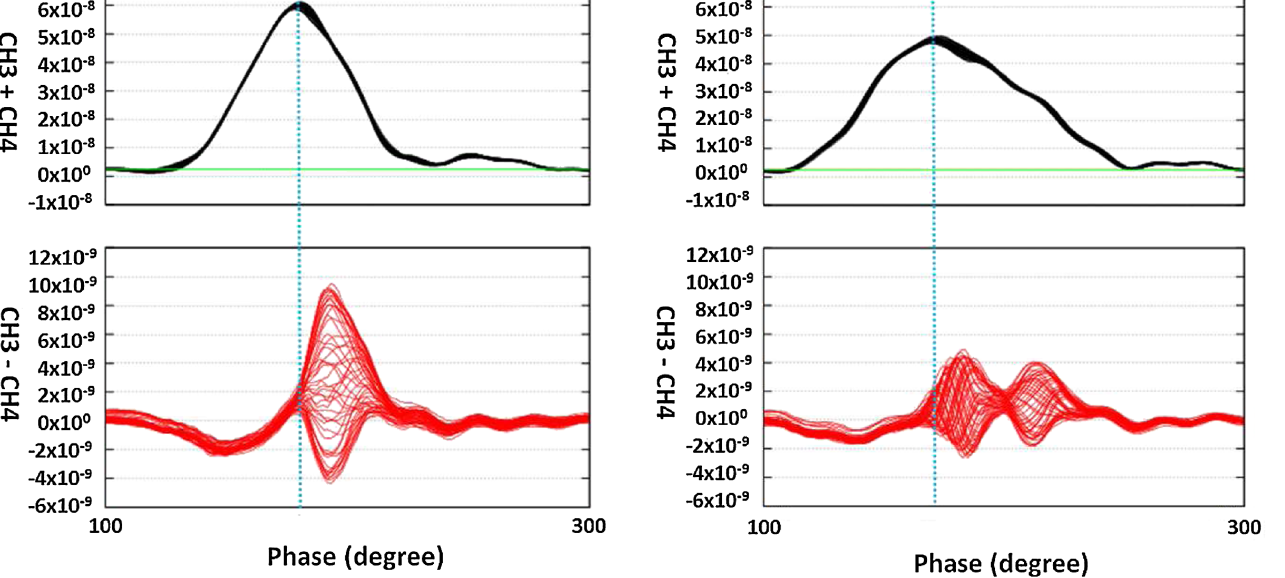
FIG. 6. (Color) The vertical centroid oscillations, case 1, mea- sured at 13.72 ms for 50 consecutive turns. The blue line indicates that the front edge of the oscillation region locates at the intensity